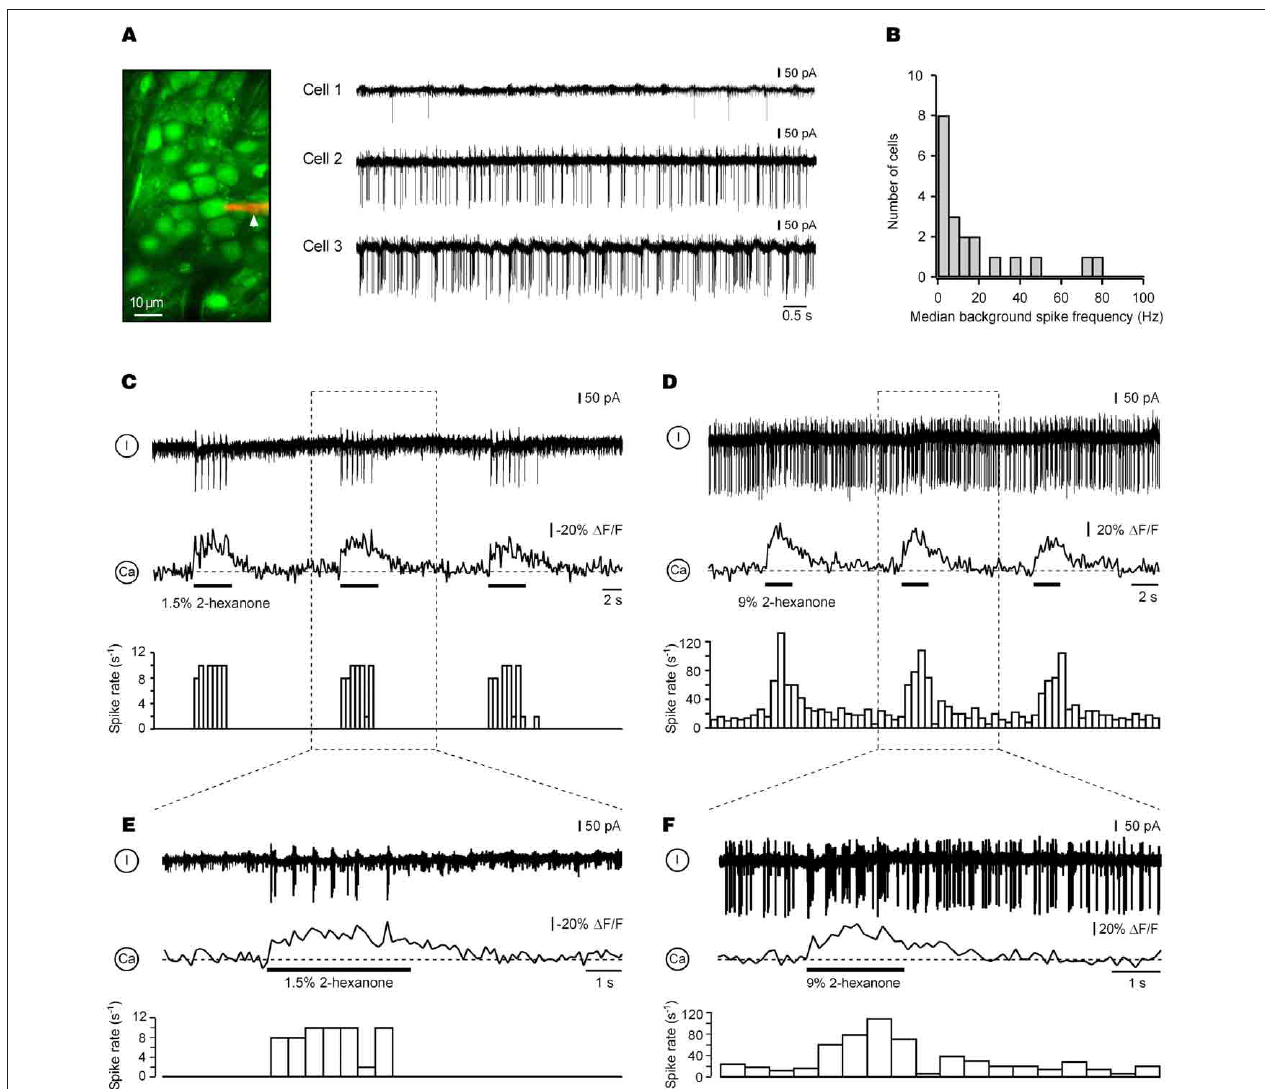
FIGURE 3 | Electrical activity underlyingON calcium responses in juxtaglomerular neurons.(A) Right: background action potentials of juxtaglomerular neurons recorded in the loose patch mode before odorant presentation. Theimageintheleftpanelshowsapatchpipette filledwith50 µ M of AlexaFluor 594 (arrowhead) attached toCell2.Thethree cellswererecorded in different experiments. (B) Distribution of the median background spike